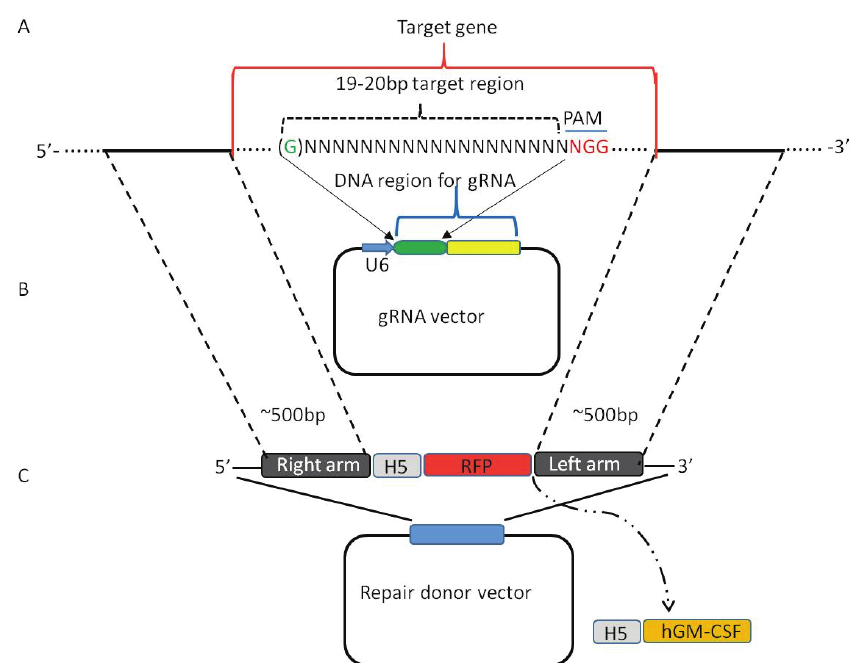
Figure 1. Construction of gRNA vector and repair donor vector for creation of a mutant vaccinia virus. ( A ) A 19mers or 20mers gRNA target sequence with/without a G at 5 ′ end is designed within the target gene; ( B ) DNA sequence of a gRNA target region is cloned into a gRNA vector using U6 at the promoter;